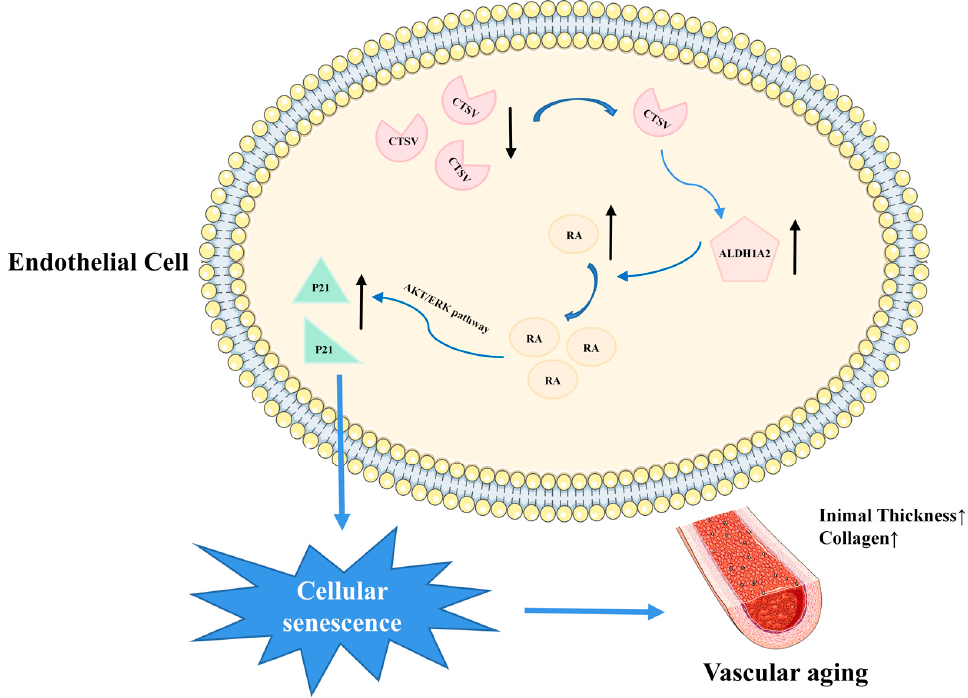
Figure 8. Schematic depiction of the mechanism of CTSV in endothelial cell senescence. CTSV decreased in senescent endothelial cells, leading to increased ALDH1A2, activated AKT/ERK1/2, enhanced P21 expression, and therefore promoted cellular senescence and vascular aging.